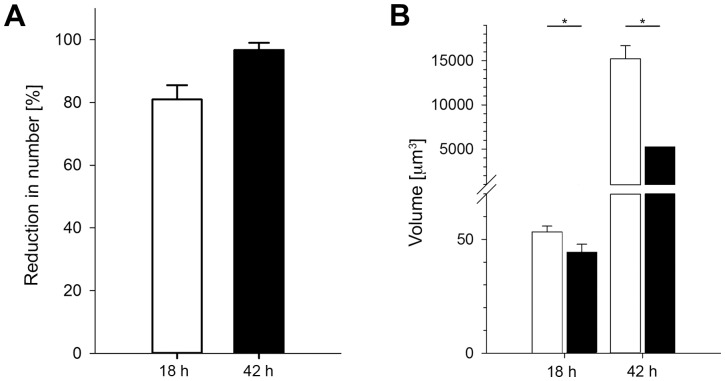
Inhibition of LS development after infection of immunized mice.Naïve or Pyfabb/f(−) immunized BALB/c mice were infected with 3×105 PyXNL-GFP sporozoites. Immunized mice were infected 2 weeks after the second booster. At 18 h or 42 h post-infection, livers were removed and LS parasites were quantified in fresh unfixed liver tissue. Using vibratome sections of known thickness and a region of interest of a defined size, the number of LS was counted and normalized to a volume of 1.3 cm3 (approximate liver volume of adult mice). Panels (A) and (B) show the reduction in LS number and volume, respectively, in Pyfabb/f(−) immunized mice compared to naïve mice. *  =  p<0.05.